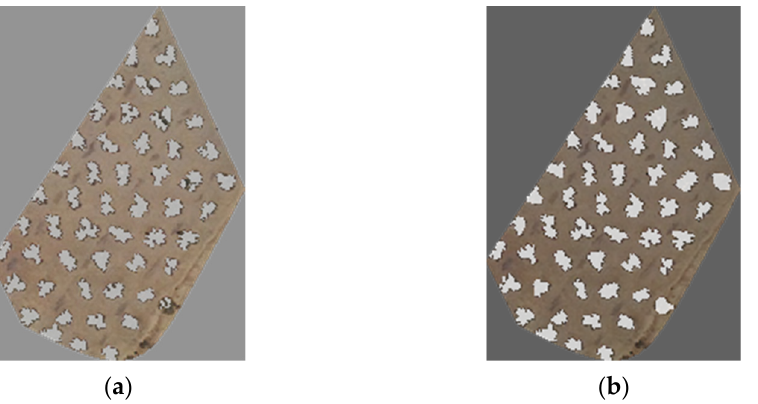
Figure 4. Example of observer correction in photo: ( a ) FCC calculated by the tool; ( b ) FCC corrected by the observer.